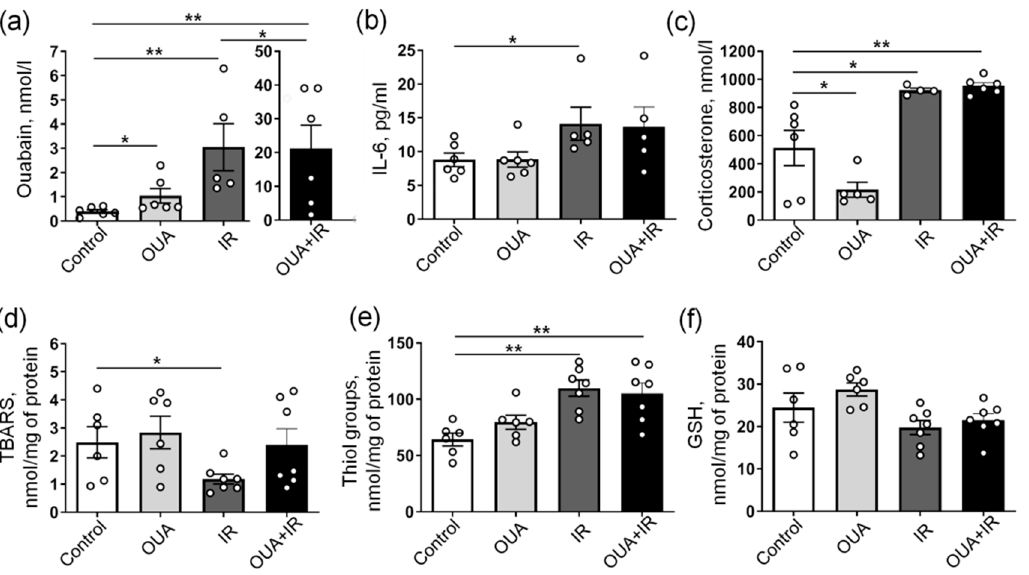
Figure 3. Biochemical responses to chronic administration of exogenous ouabain (OUA), ionizing radiation (IR), and their combination (OUA + IR). ( a – c ) Concentrations of ouabain, IL-6, and corticosterone measured in the blood serum, as indicated. ( d ) Thiobarbituric acid reactive substance (TBARS) concentrations, ( e ) the concentration of thiol groups, and ( f ) total glutathione (GSH) measured in homogenates of the diaphragm muscle. The number of rats corresponds to the number of symbols. * and **, p < 0.05 and 0.01 (two-way ANOVA followed by Bonferroni multiple comparisons test).